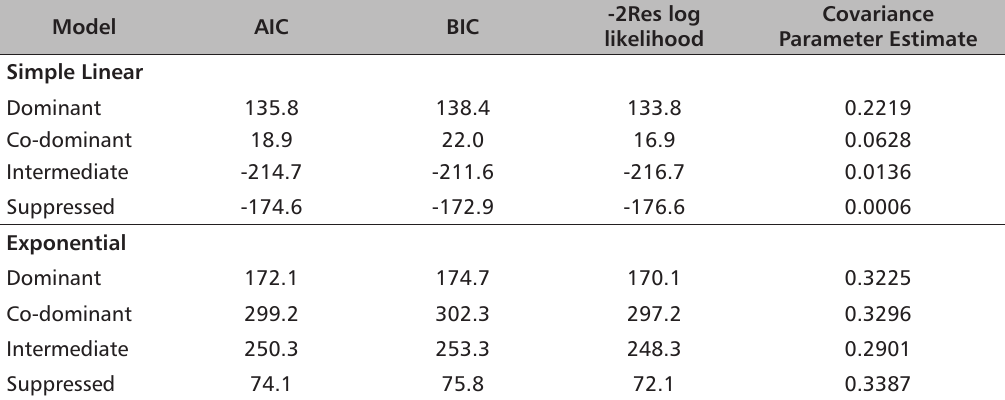
TABLE 2. Model fitting statistics under the two modeling approaches across the crown